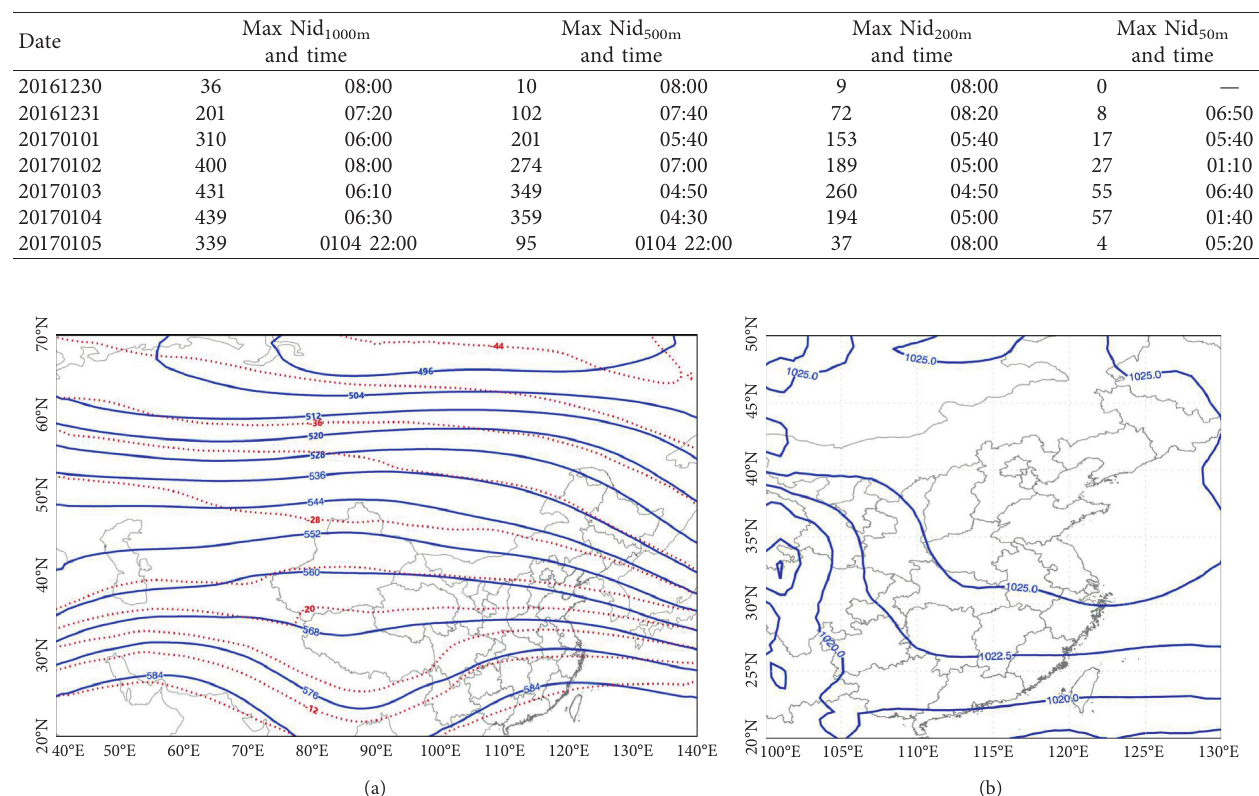
Table 1: Maximum number of stations and corresponding time (BT) of fog, DF, SDF, and EDF in the study area from December 30, 2016, to January 5,